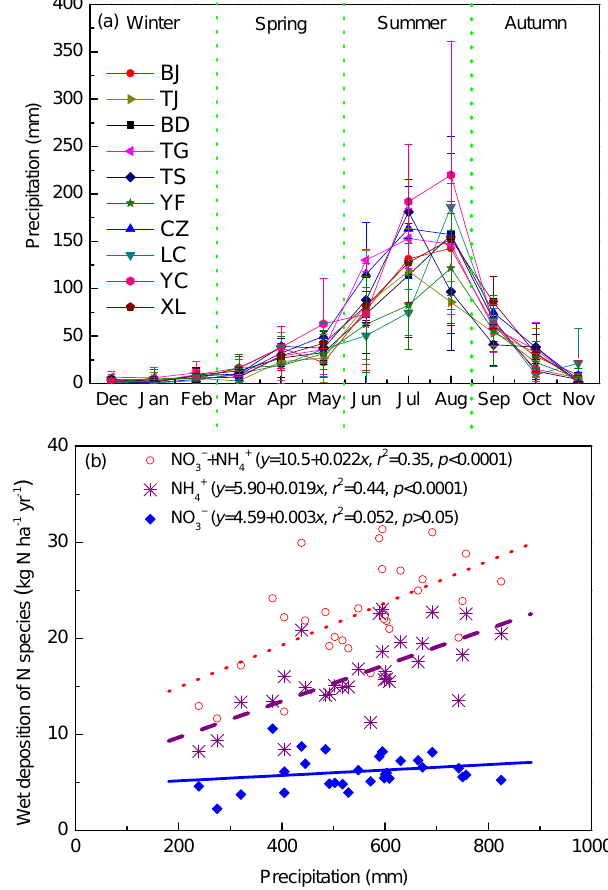
Fig. 4. Seasonal variations of precipitation at the ten selected sites (a) and the annual precipitation against wet deposition of nitrogen in Northern China (b) . The seasonal precipitation data are the monthly mean ± standard deviations of three-year observations (from De- cember 2007 to November 2010). The definition of the site codes is found in the caption of Fig.